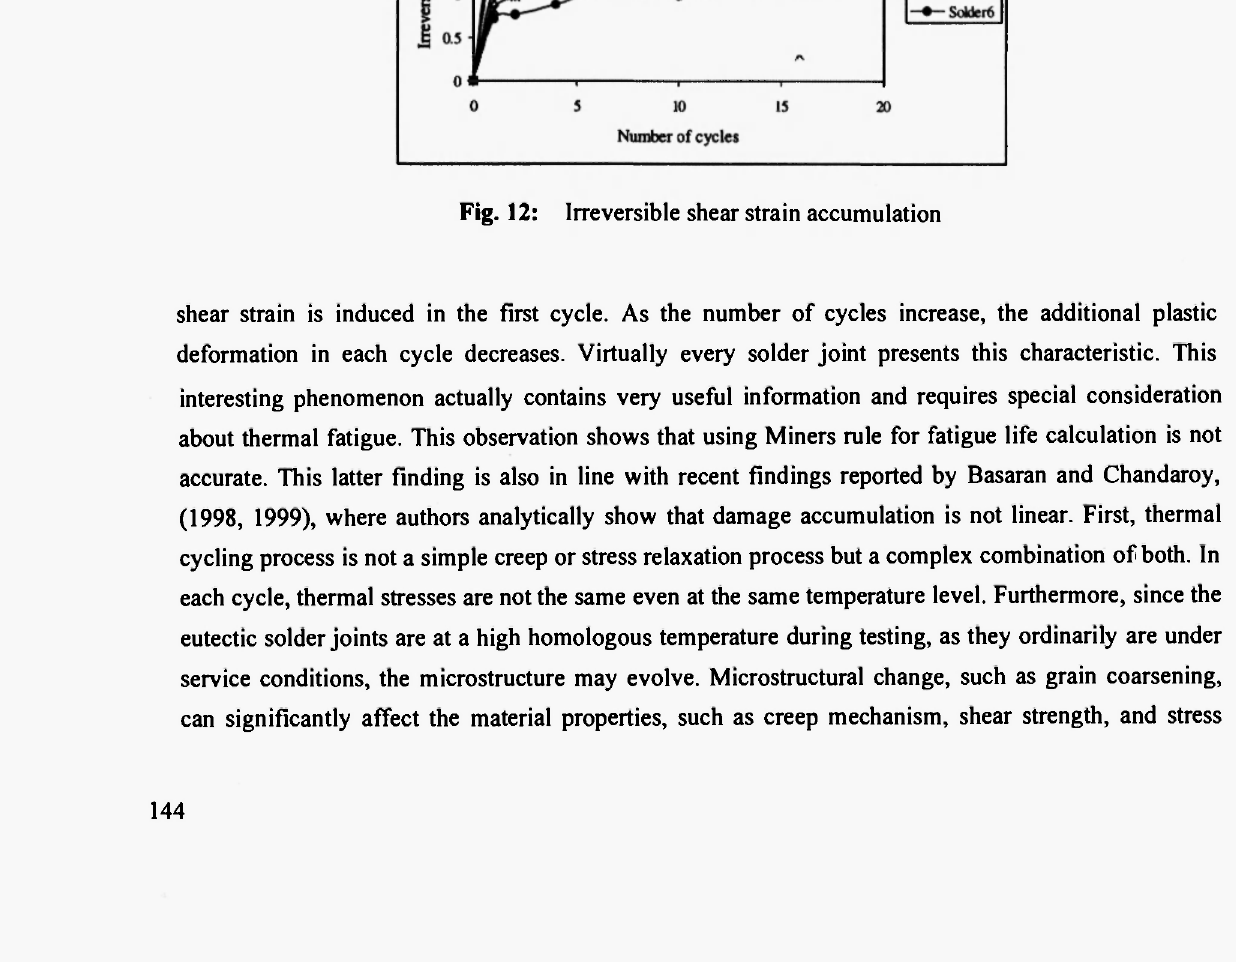
Irreversible shear strain distribution